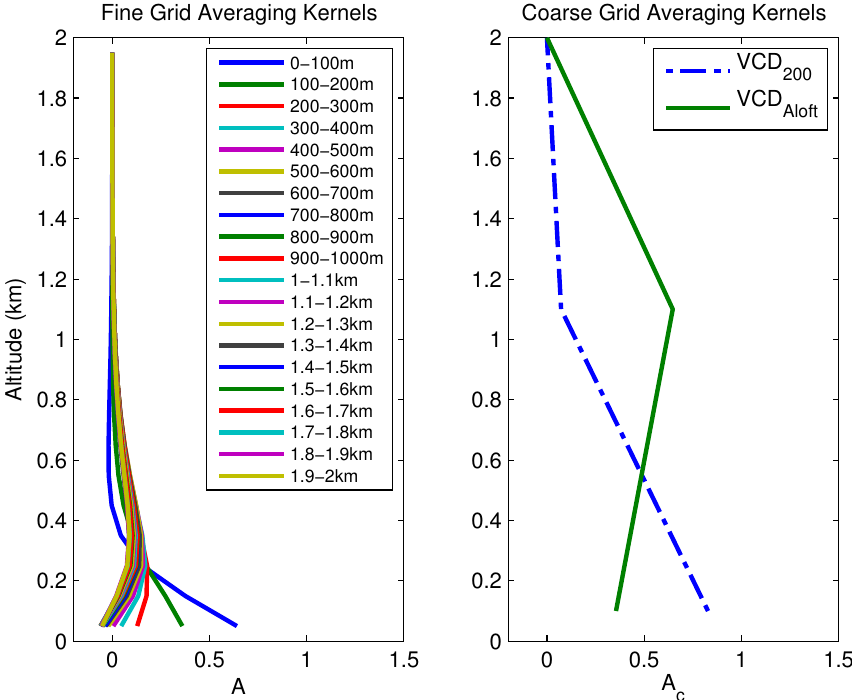
Figure 2. An illustration of the grid coarsening of the BrO averaging kernels. These averaging kernels correspond to the retrieval shown in green in Fig. 1. Averaging kernels for the original retrieval (left) and for the coarse grid